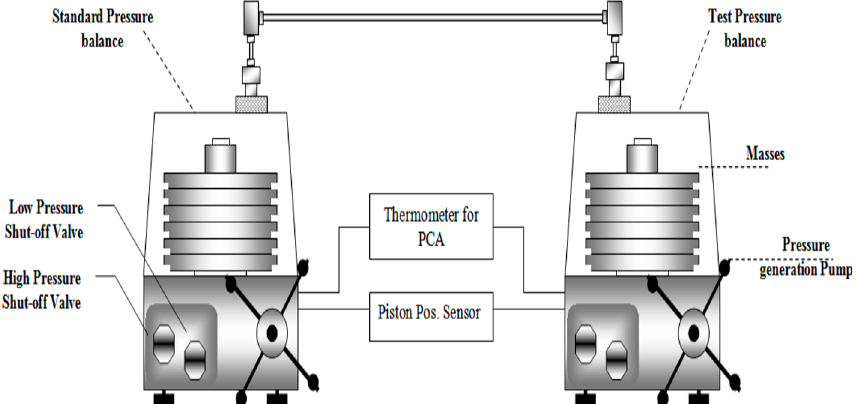
Fig. 2. Experimental set-up illustrating the method of cross- fl oating between a UUT vs. a RS.